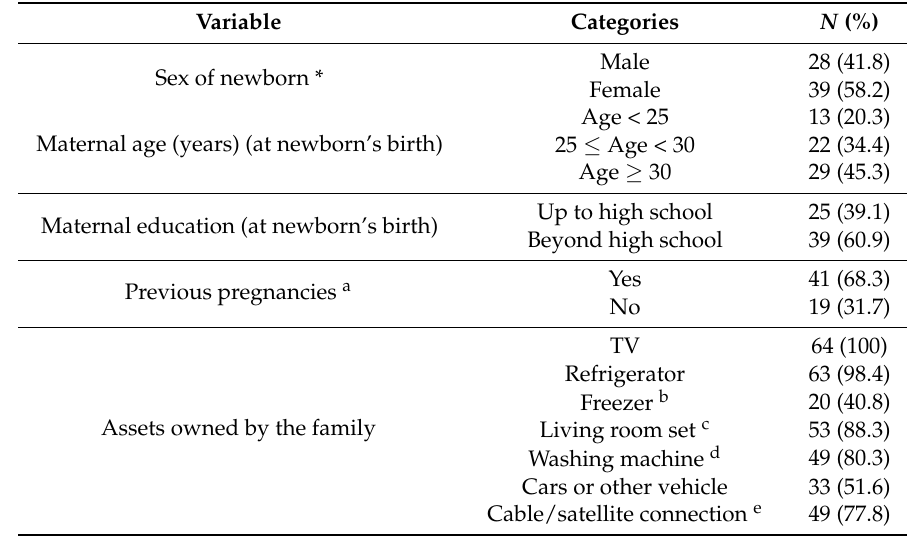
Table 1. Individual and household characteristics of the study participants ( N = 67 newborns from 64 mothers) from the Jamaican Birth Cohort (JA Kids)